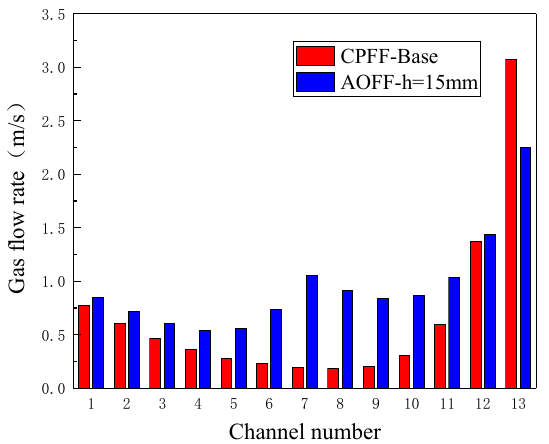
Figure 8. The chart of gas flow rate in each cathode channel for the CPFF pattern and the AOFF pattern at Vcell = 0.5 V.